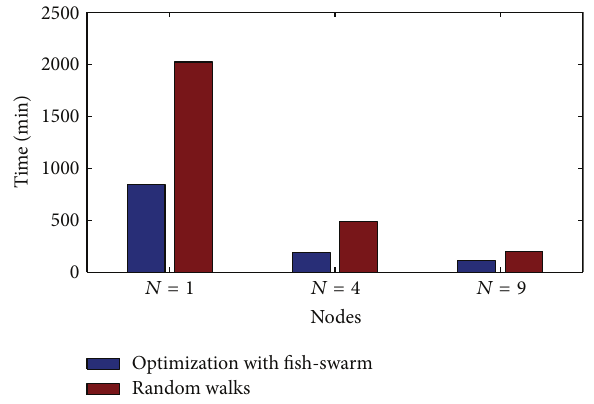
Figure 10: Average rescuing time versus node number.